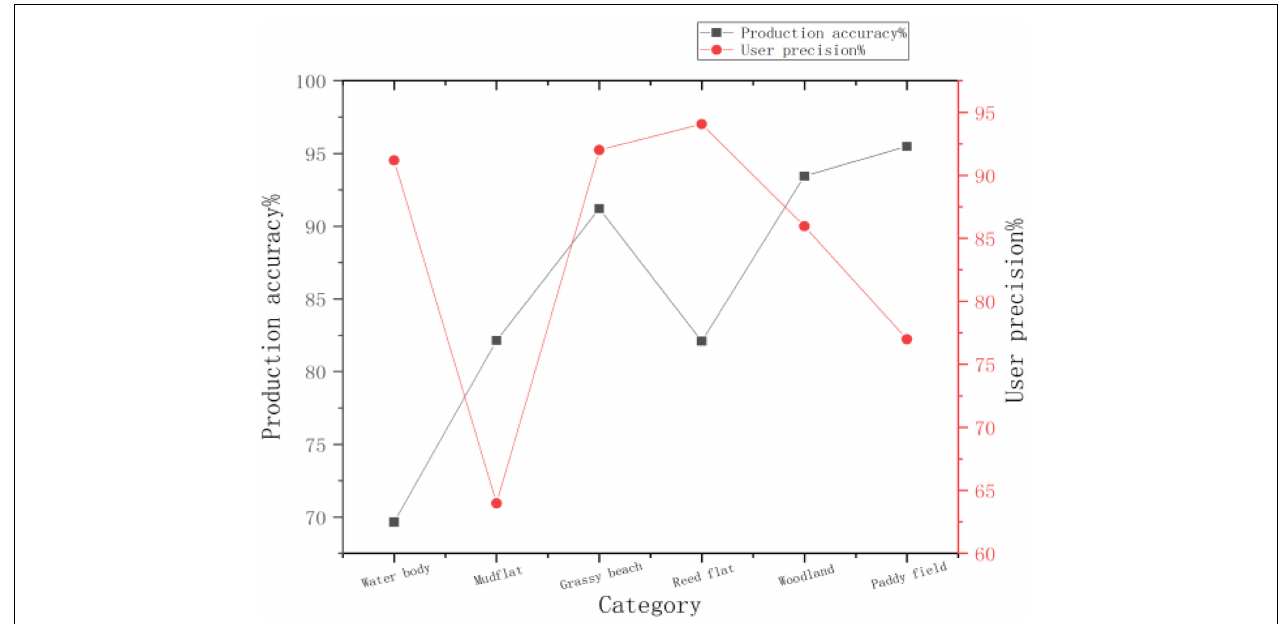
FIGURE 3 | Accuracy comparison